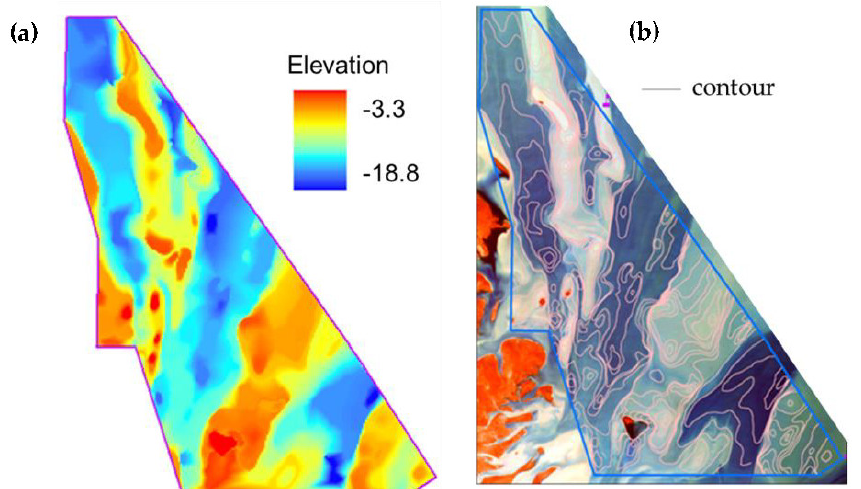
Figure 5. Comparison with surveyed data and extracted image of sand ridge lines; ( a ) digital elevation model (DEM) based on surveyed data; ( b ) overlay map of image and contours of DEM.